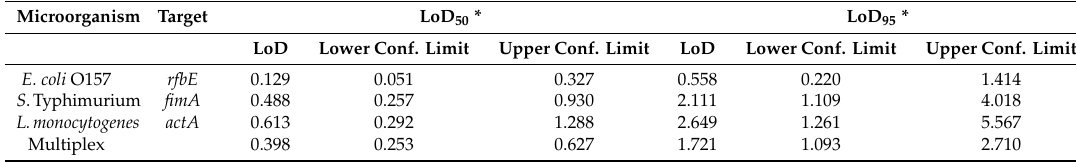
Table 6. Determination of the LoD based on fractional POD